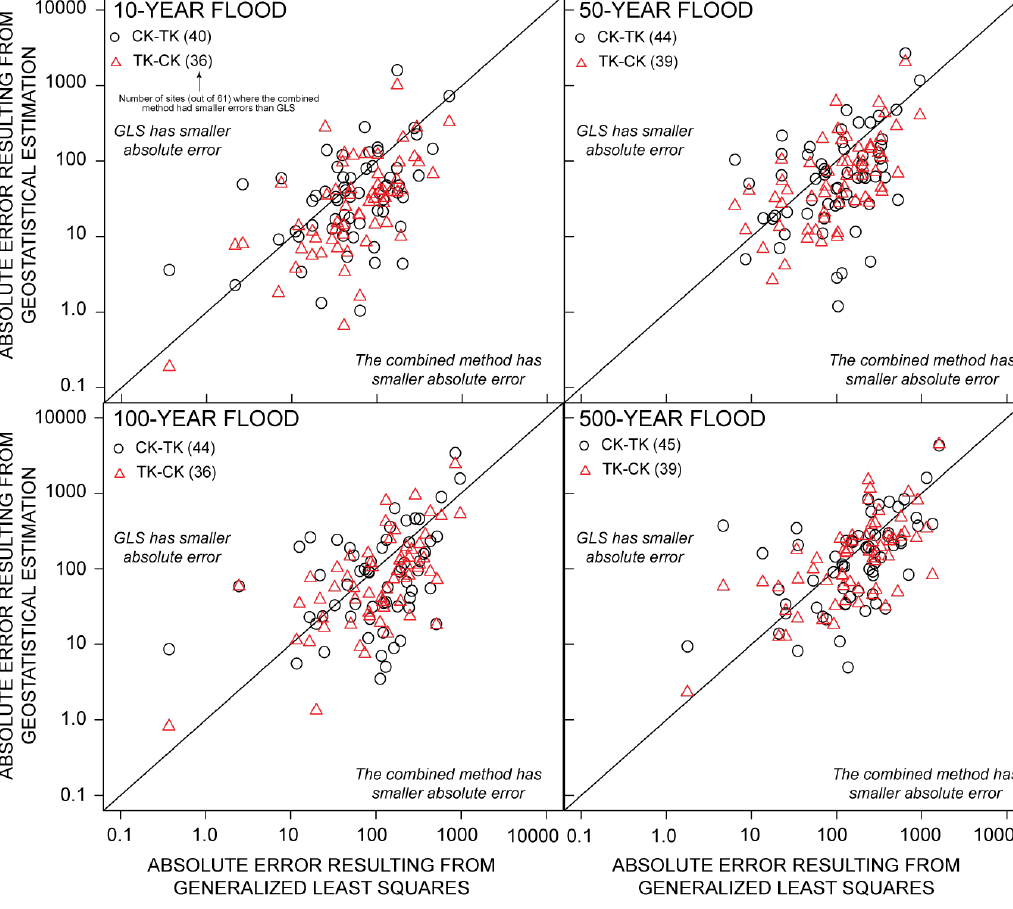
Fig. 6. Comparison of the absolute errors between empirical and predicted flood quantiles resulting from the coupling of topological with canonical kriging of the residuals (TK-CK) and canonical kriging with topological kriging of the residuals (CK-TK) to the absolute error resulting from generalized least squares